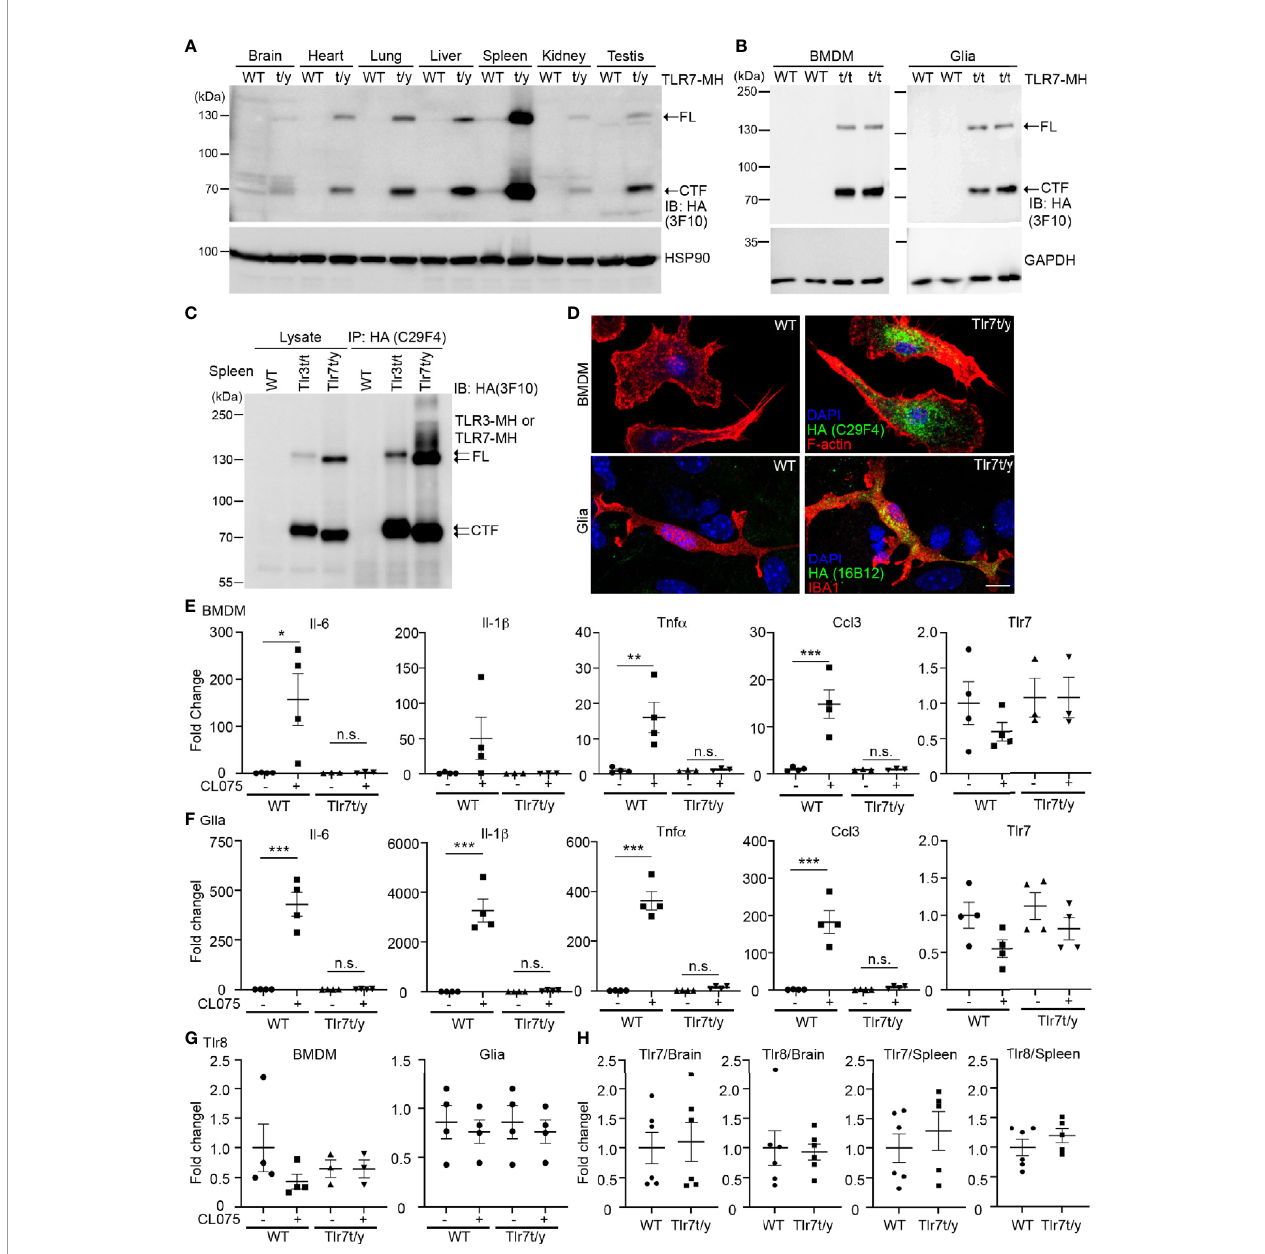
FIGURE 6 | C-terminal Myc-HA dual tagging results in inactivation of TLR7. (A, B) Immunoblotting using anti-HA antibodies was performed to detect the expression of TLR7-MH in Tlr7 t/y tissues (A) and Tlr7 t/t cells (B) . Different organs and BMDMs and glia cell cultures were examined, as indicated. Samples prepared from WT littermates were used as negative controls. HSP90 and GAPDH were used as a loading control. FL, full-length TLR7-MH; CTF, C-terminal fragment of TLR7-MH. (C) Distinct levels of proteolyzed TLR3-MH and TLR7-MH in mouse spleen. Anti-HA antibody (C29F4) was used to precipitate TLR3-MH and TLR7-MH proteins from Tlr3 t/t and Tlr7 t/y mouse spleens, respectively. WT mice were used as a negative control. The IP complex was then subjected to IB analysis using anti-HA antibody (3F10). FL: full-length TLR3-MH or TLR7-MH, CTF: C-terminal fragment of TLR3-MH or TLR7-MH. (D) Immunostaining of BMDMs and glial cells using anti-HA and anti-IBA1 (for microglia) antibodies was performed, as indicated. Phalloidin and DAPI were used to label F-actin and nuclei, respectively. Scale bars, 10 m m. (E – G) BMDMs and glia cells prepared from WT and Tlr7 t/t mice were treated with 4 m M CL075, a TLR7 agonist, for 6 h. Expression levels of Il-6 , Il-1b , Tnfa , Ccl3 , Tlr7 and Tlr8 were then determined using quantitative RT-PCR and normalized against the internal control Hprt . (H) Levels of Tlr7 and Tlr8 mRNA are similar between WT and Tlr7 t/y mouse organs. Brain and spleen of WT and Tlr7 t/y mice were harvested for RNA extraction and then subjected to quantitative RT-PCR to analyze levels of Tlr7 and Tlr8 , normalized against the internal control Hprt . Data are represented as mean ± SEM ( error bars ). Each dot indicates the result of one independent culture. *p > 0.05; **p > 0.01; ***p > 0.001; n.s., non-signi fi cant. (E – G) Two-way with Bonferroni ’ s multiple comparisons